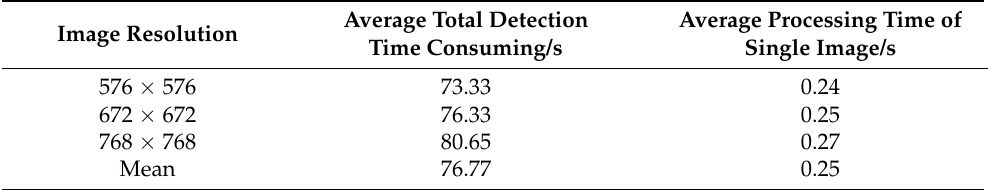
Table 3. Real-time test results of the proposed model under different image resolutions.